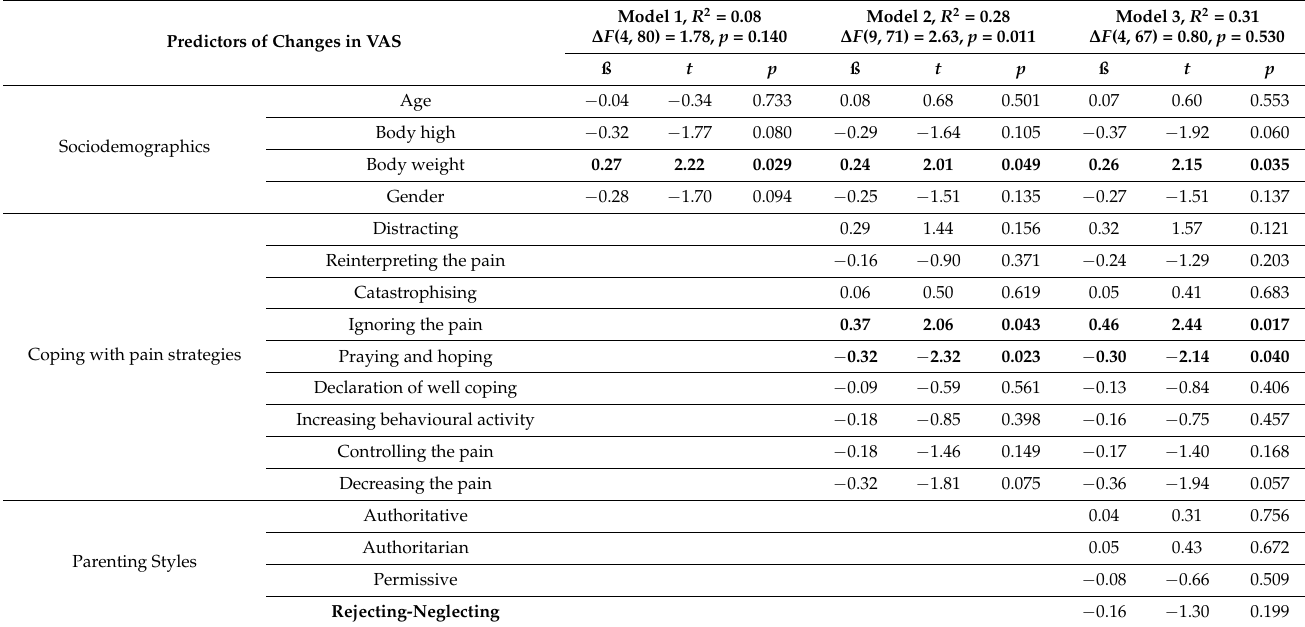
Table 4. Hierarchical linear regression predicting changes in subjective pain (VAS) after physical